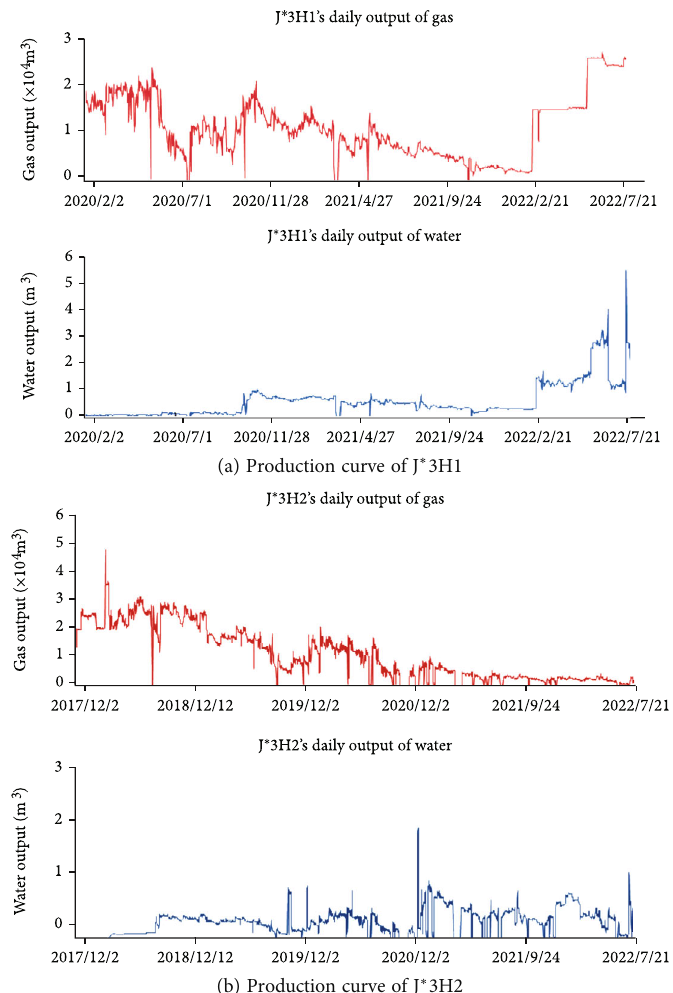
Figure 10: Production curves of two horizontal wells on Shaan2 ∗ 6 well group. (a) Production curve of J ∗ 3H1. (b) Production curve of J ∗